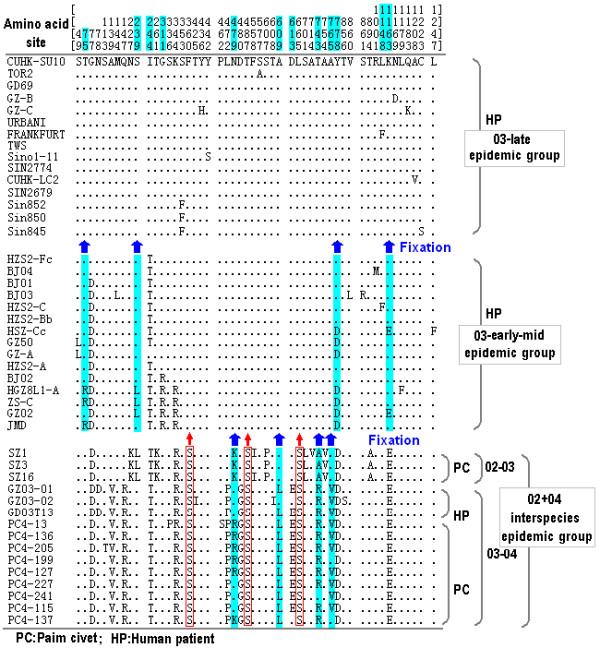
Amino acid variations of 45 S proteins. The amino acid sequence of CUHK-SU10 strain isolated from 03-late epidemic group was used as the reference sequence. The shadows represent the sites or residues under positive selection with posterior probability ≥ 0.9. The red sashes highlight three special sites where amino acids were replaced and fixed in all 03 human strains, suggesting selective sweep acting on the S gene.